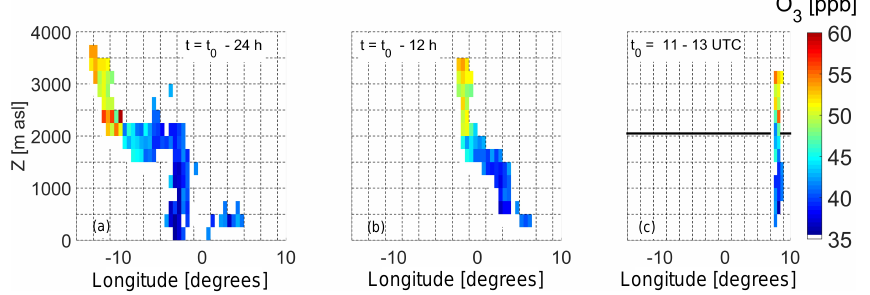
Figure 11. Temporal evolution of air mass origins between 11:00 and 13:00UTC on 6 September 2011. The trajectory positions are colour coded by mixing ratios of ozone as measured along the flight leg. The data are binned by 0.5 ◦ longitude and 250m altitude (for details see text). The black line marks the maximum PBLH during that time.